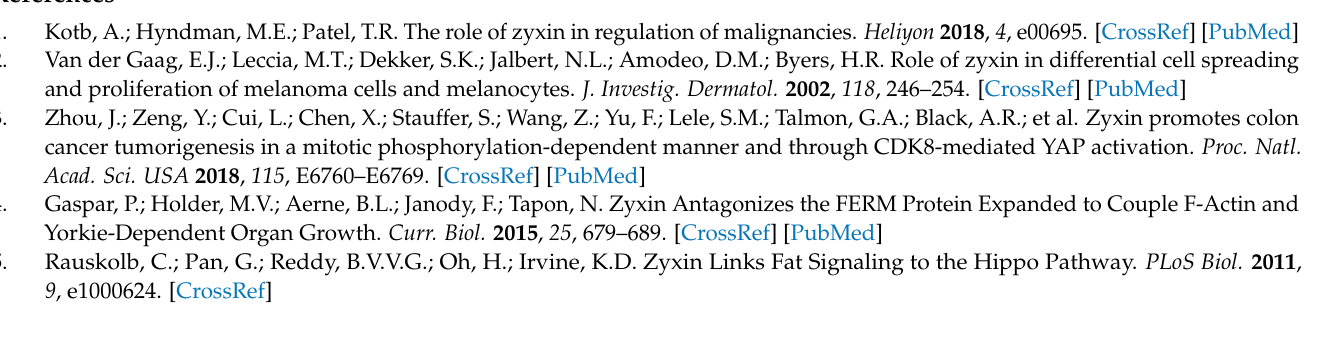
(PTM) sites of Zyxin family proteins.; Supplementary Figure S4: Validation of the homology models generated for Zyxin family proteins.; Supplementary Figure S5: Structural alignment analysis of the Zyxin Lim domain by DALI server, indicates the similarity with transcription regulators.; Supplementary Figure S6: Adaptive Poisson-Boltzmann Solver (APBS) electrostatics and Yellow- Red-Blue (YRB) showing surface potential and hydrophobicity calculations, respectively; of Zyxin family Lim domains.; Supplementary Figure S7: The protein expression profiles of the Zyxin family proteins in different cancers (retrieved from Genevestigator) are presented as bar graphs. (A) Zyxin; (B) LIMD1; (C) Ajuba and (D) LPP.; Supplementary Figure S8: The protein expression profiles of the Zyxin family proteins in different cancers (retrieved from Genevestigator) are presented as bar graphs. (A) TRIP6; (B) FBLIM; (C) WTIP.; Supplementary Figure S9: Protein-protein interaction (PPI) analysis of Zyxin.; Supplementary Figure S10: Protein-protein interaction (PPI) analysis of LimD1.; Supplementary Figure S11: Protein-protein interaction (PPI) analysis of LPP.; Supplementary Figure S12: Protein-protein interaction (PPI) analysis of (A) FBLIM and (B) WTIP.; Supplementary Figure S13: Protein-protein interaction (PPI) analysis of Ajuba.; Supplementary Figure S14: Protein-protein interaction (PPI) analysis of TRIP6.; Supplementary Figure S15: Protein-protein interactions and pathway analysis, (A) Omnipath showing the zyxin involvement in Akt/IL7R pathway; (B) STITCH analysis; (C) STRING analysis.; Supplementary Table S1: Distribution of hydrophobic amino acids in each LIM domain of human Zyxin family proteins.; Supplementary Table S2: Ohnolog analysis of Zyxin family proteins. Supplementary Table S3: List of all online servers/databases used in the